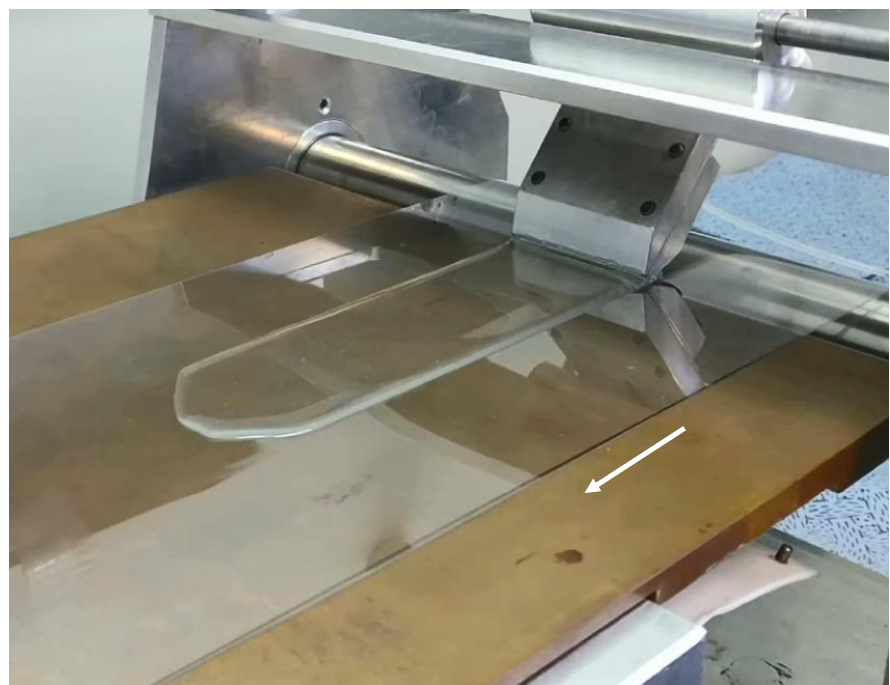
Figure 2. A photograph of slot-die roll to roll machine shown depositing a Chi-TEOS IPN hydrogel onto a PET substrate over a hotplate. The arrow shows the direction of travel.